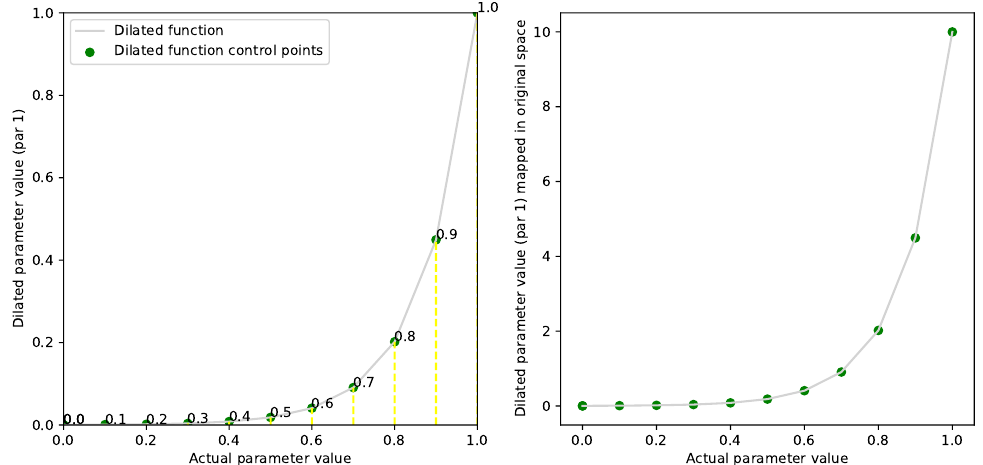
Figure 3. E ffect of the anti-log DF. ( Left ): control points encoding the DF. ( Right ): effect of the mapping of a particle’s component ( x axis) in the original search space of the PE problem ( y axis).